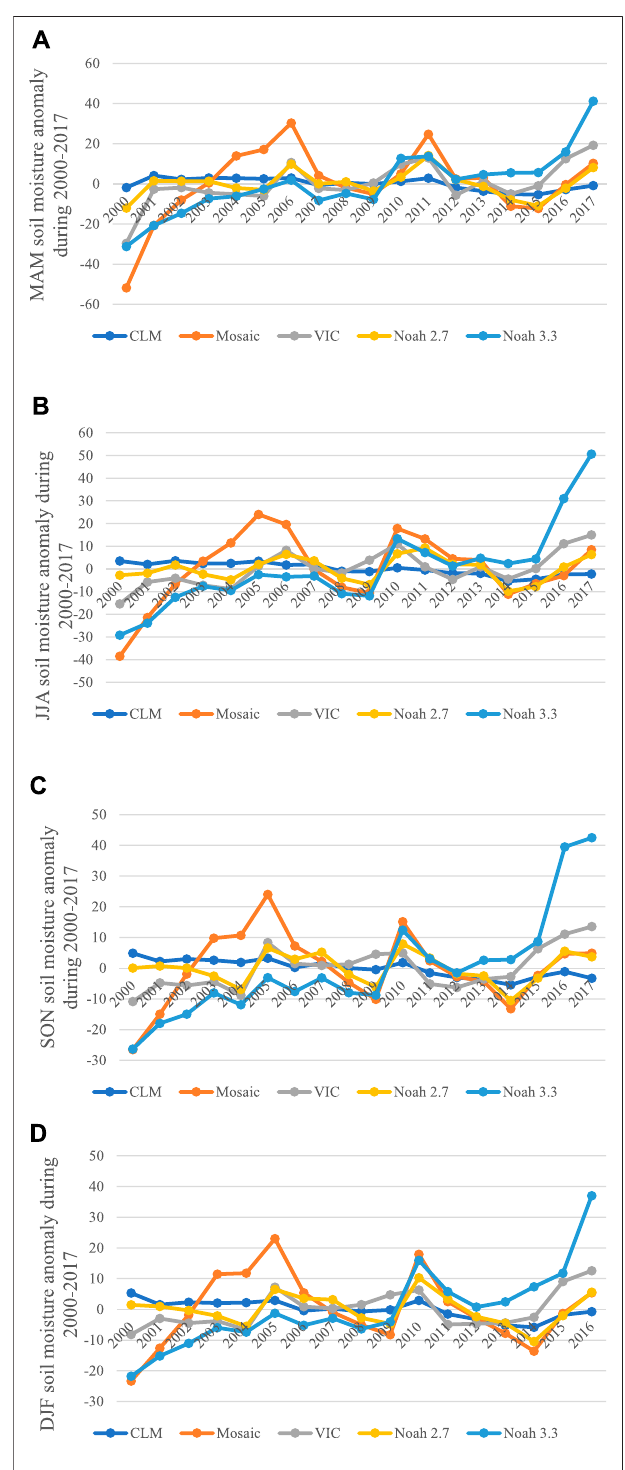
FIGURE 3 | Anomaly of seasonal soil moisture of the fi ve different models: CLM, Mosaic, VIC, Noah 2.7 and Noah 3.3 over Xinjiang during the period of 2000 – 2017, (A) MAM, (B) JJA, (C) SON and (D)